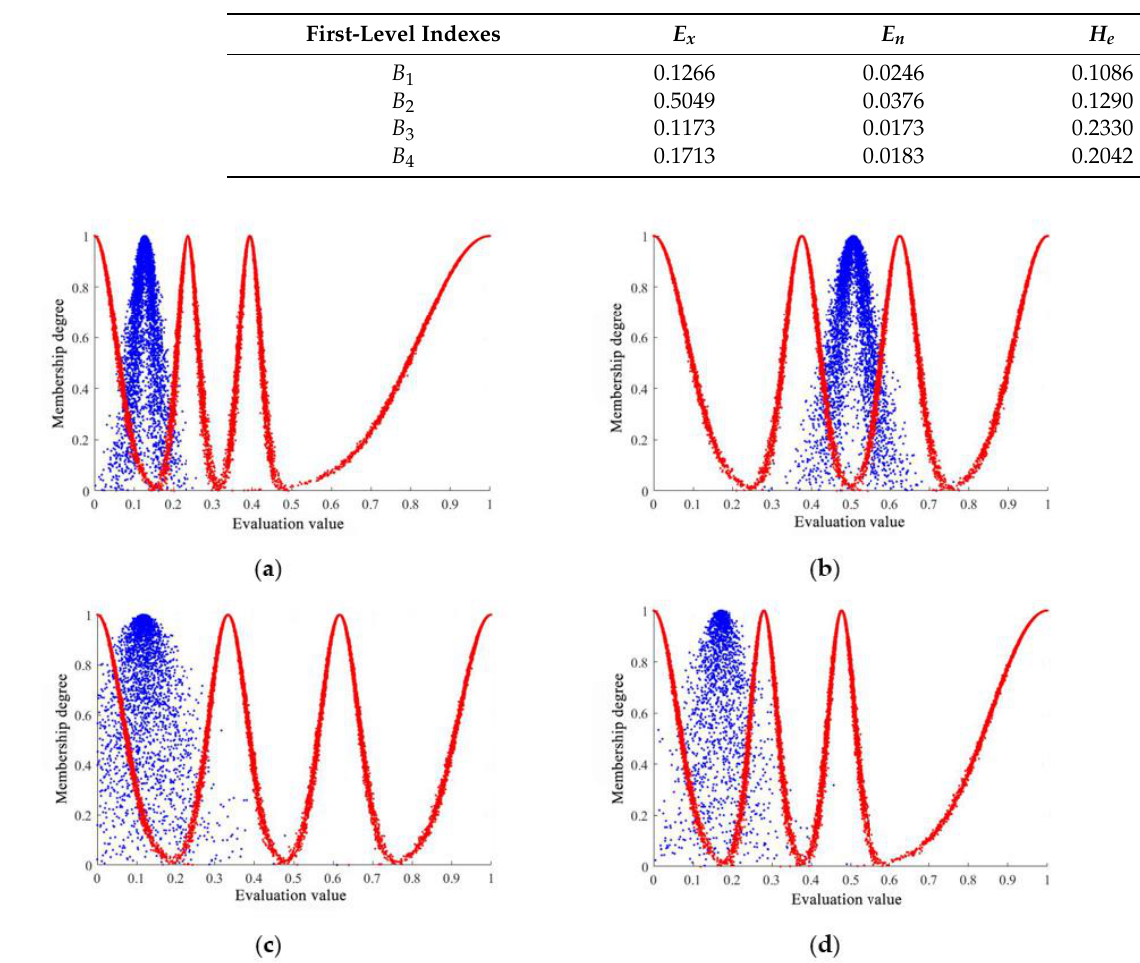
Figure 6. Cloud pictures of comprehensive risk evaluation indexes in criterion level: ( a ) Support conditions; ( b ) Roof con- ditions; ( c ) Personnel working status; ( d ) Coal body status.